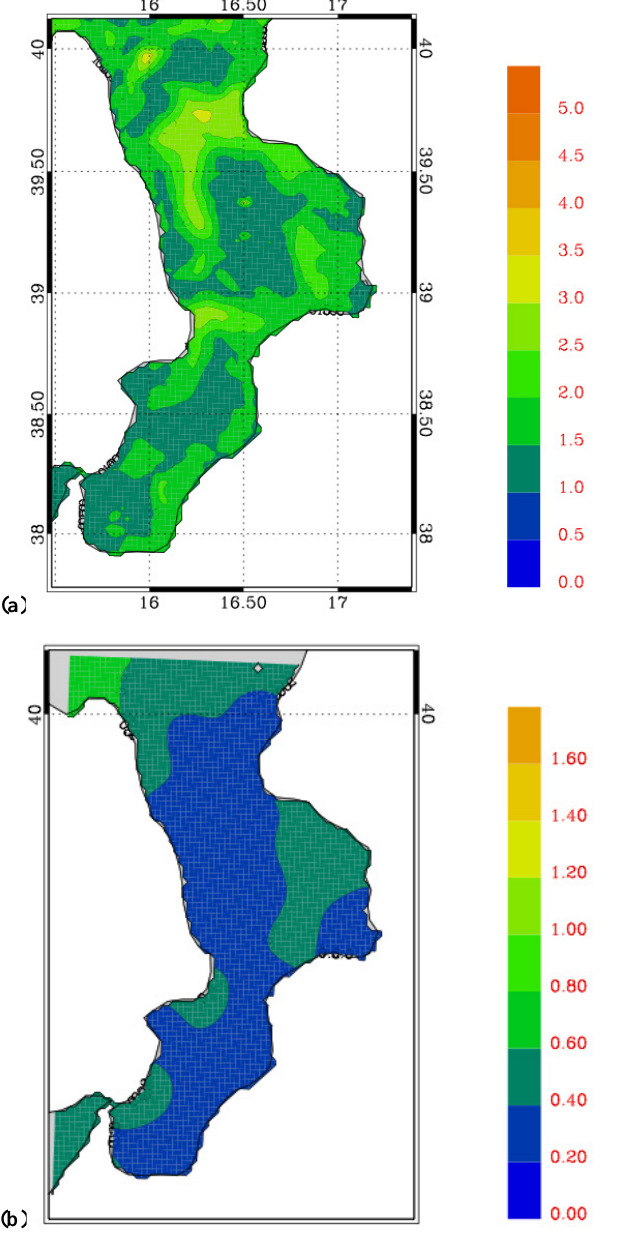
Figure 3. (a) Mean temperature RMSE ( ◦ C) for the second-day forecast; (b) averaged precision ( ◦ C 2 ) for mean